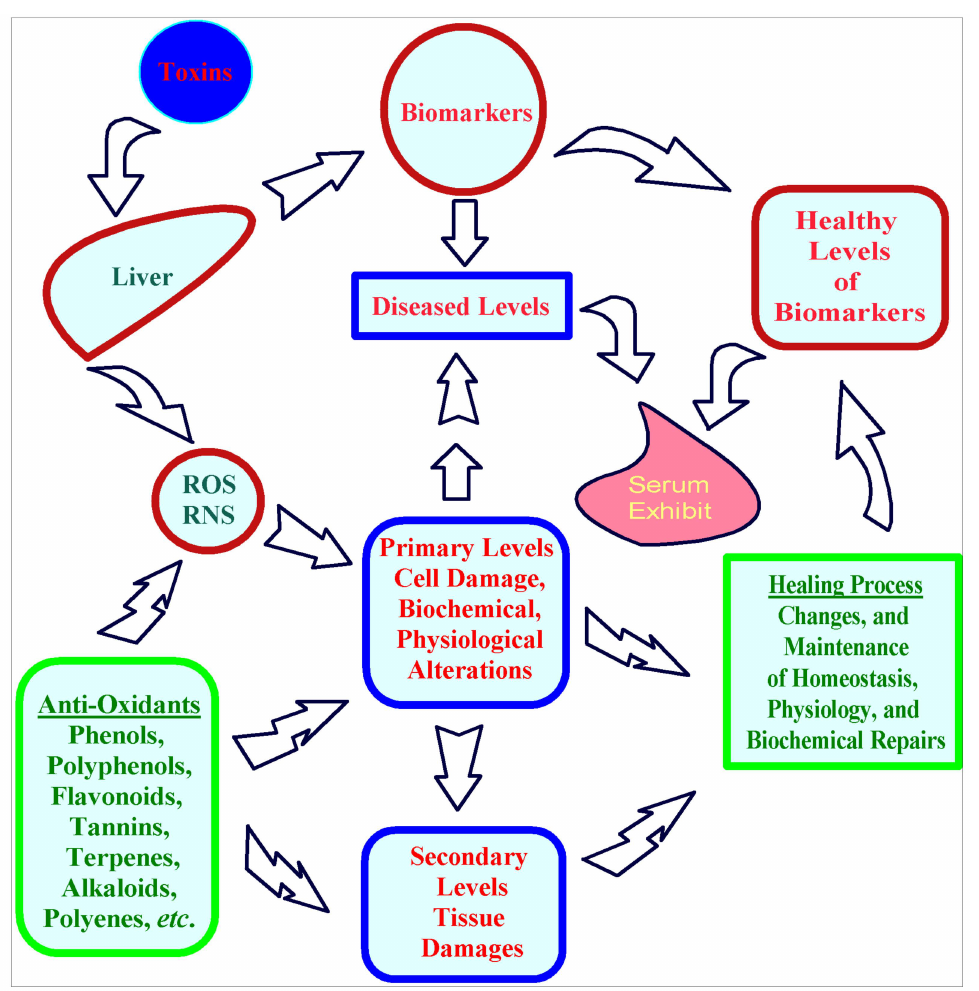
Figure 5. Prospective roles of antioxidants in